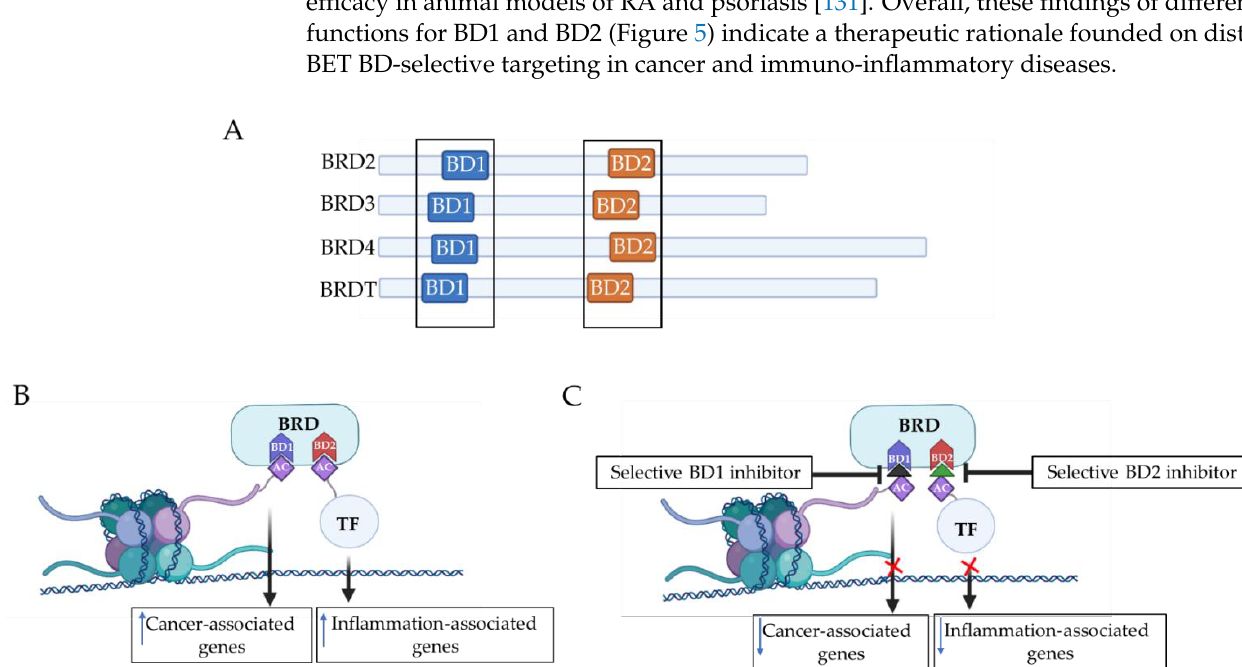
Figure 5. Selective domain targeting of BD1 and BD2. ( A ) BET proteins family of BCPs comprise the ubiquitously expressed BRD2, BRD3, and BRD4 and BRDT, which all harbor two highly conserved tandem bromodomains, BD1 and BD2, allowing them to recognize acetylated lysine. ( B ) BD1 and BD2 have distinct functions. BD1 binding is sufficient to maintain homeostatic and oncogenic gene transcription programs, while BD2 binding is required to promote an inflammatory transcriptional response. ( C ) Domain-selective inhibitors for BD1 and BD2 show preferential effects on different types of cellular functions [141].